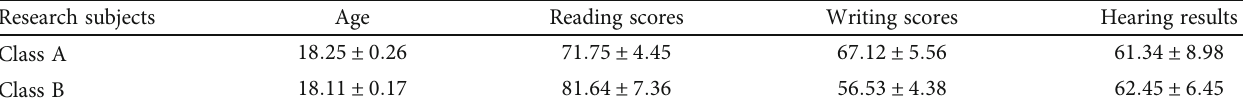
Table 1: Basic information of